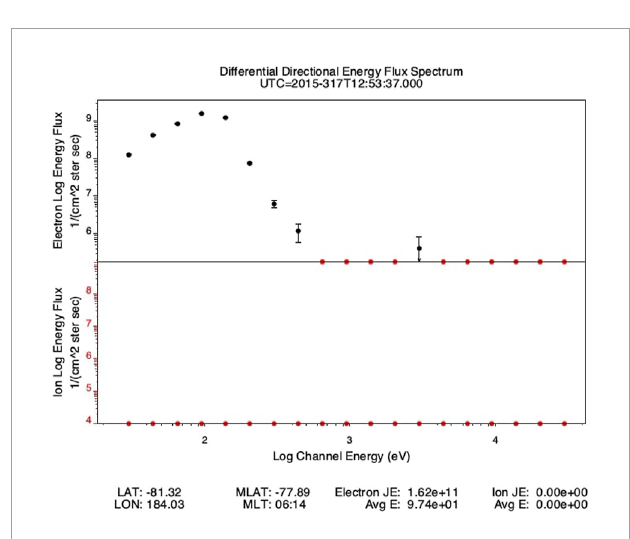
FIGURE 6 Spectrum of the particle precipitation seen at 12:53:37 in figure. The accelerated Maxwellian seen in the electron spectrum indicates electrons being pushed upward in a current. (Plot from http://